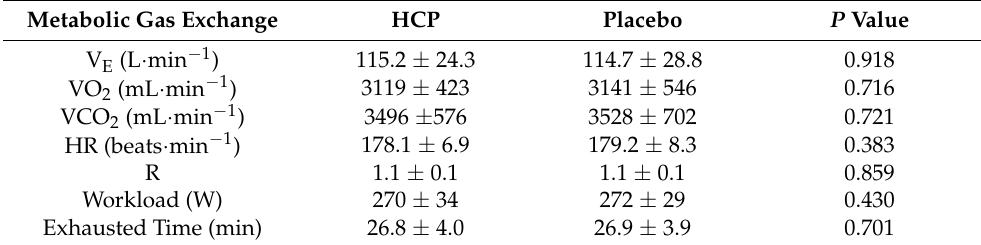
Table 2. Peak values of gas exchanges parameters, workload, and the exhausted time during incremental exercise between the HCP and placebo